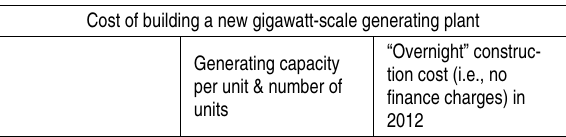
Table 2. Cost of building a new gigawatt-scale ge- nerating plant